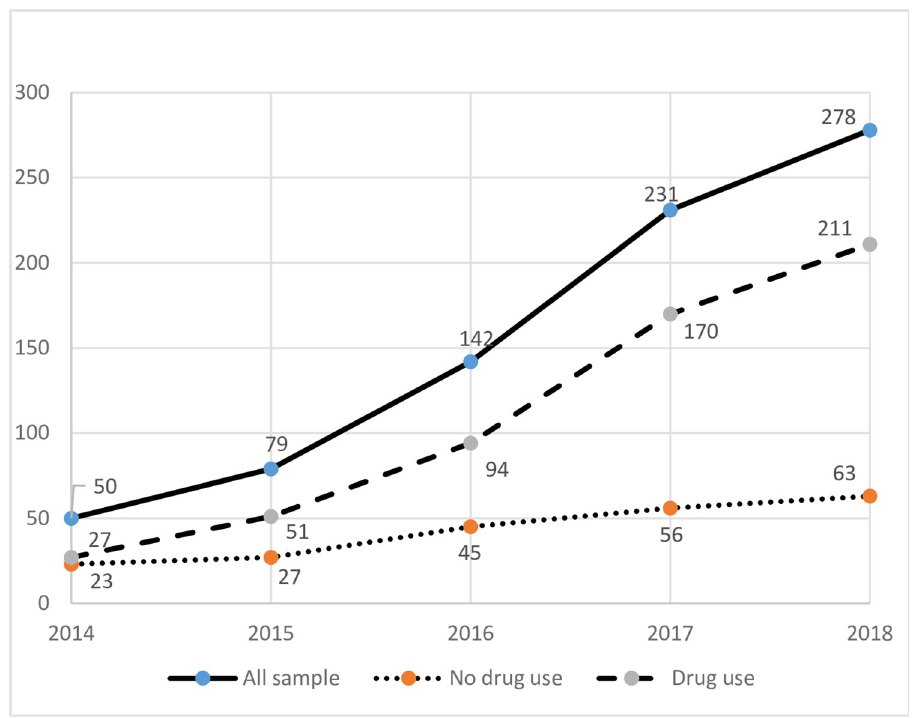
Fig 1. Frequency of infective endocarditis in West Virginia: